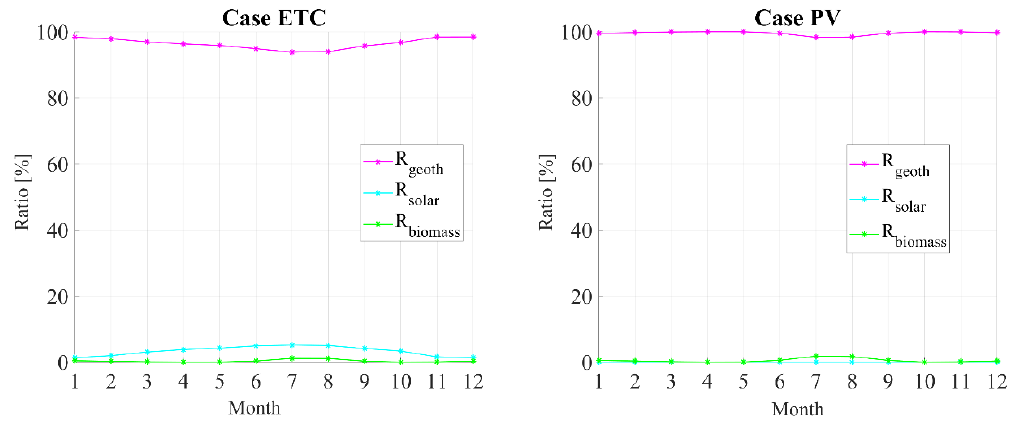
Figure 8. ORC evaporator energy ratios: Case ETC ( left ) and Case PV ( right ).